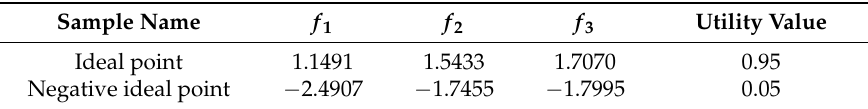
Table 1. List of the ideal point and negative ideal point.